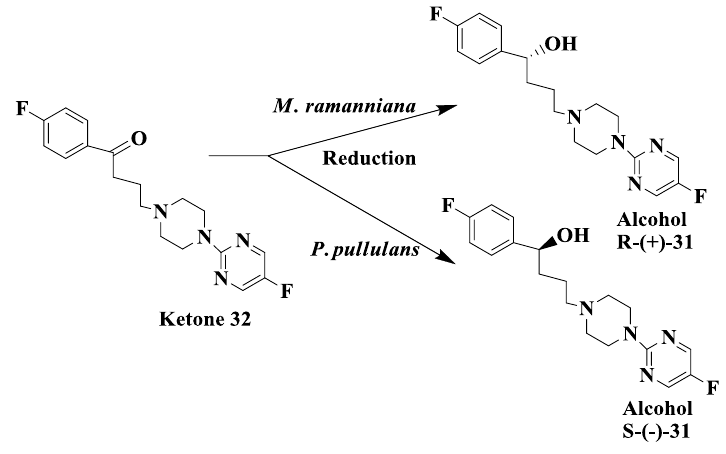
Figure 9. Antipsychotic drug: Enzymatic reduction of 1-(4-fluorophenyl)4-[4-(5-fluoro-2-